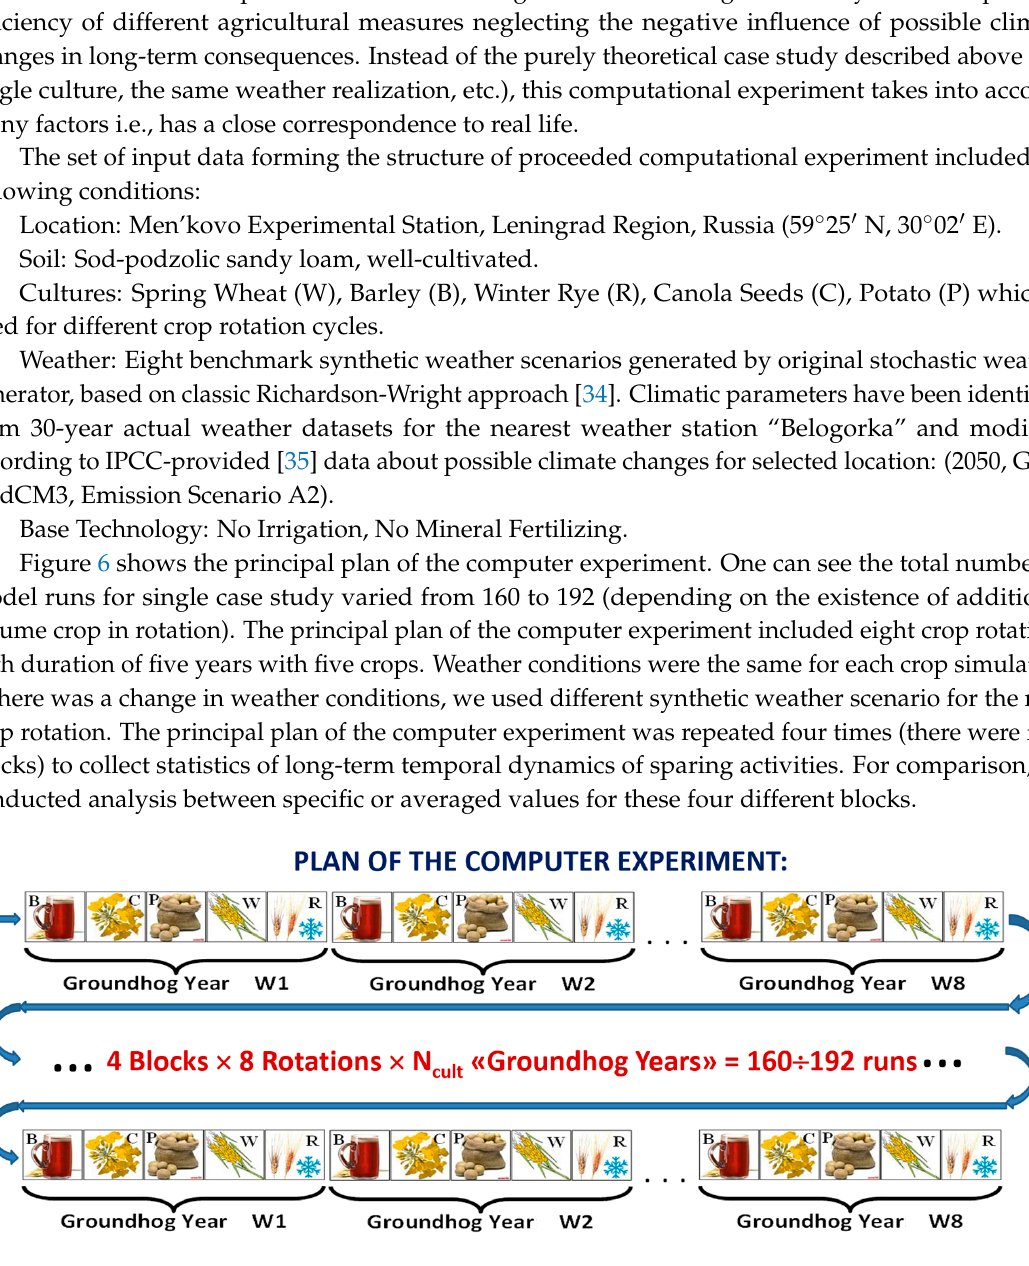
Figure 6. Plan of the computer experiment.